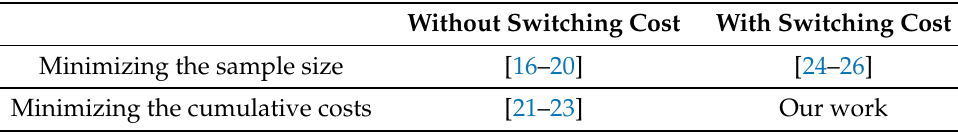
Table 1. The differences between our work with the works in